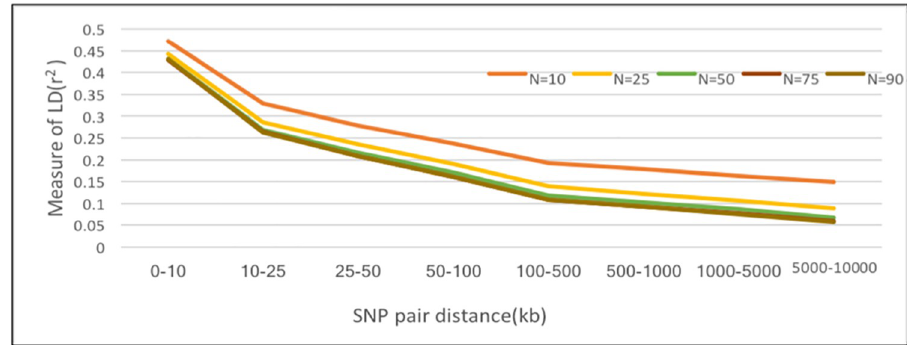
Fig 4. Mean r 2 estimates at different physical distances for different sample size.